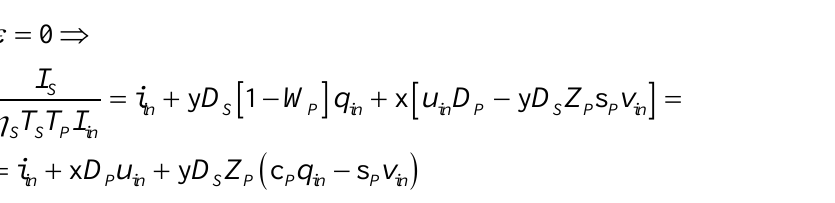
with Eq. (124) the gain ratios (Sect. 5) in Eq. in